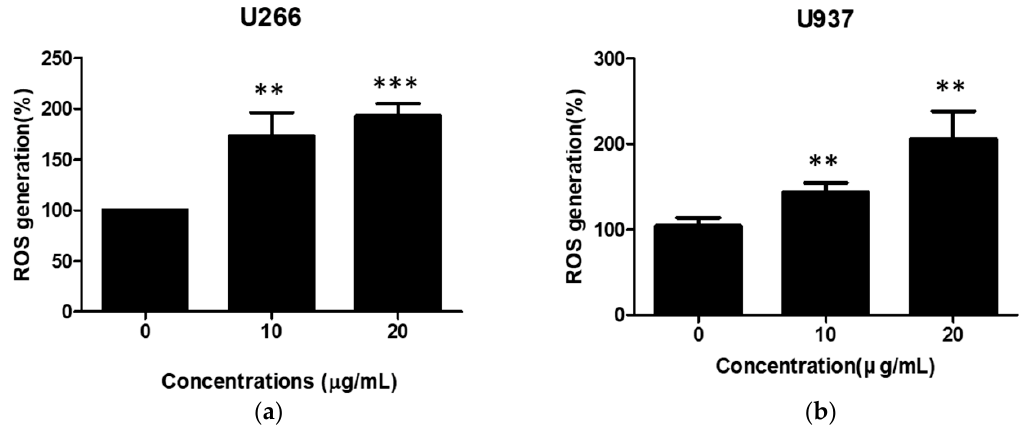
Figure 5. Effect of SSD on reactive oxygen species (ROS) generation in U266 and U937 cells. U266 ( a ) and U937 ( b ) cells were exposed to SSD (10 or 20 µ g/mL) for 24 h (sample number n = 3). ROS production was analyzed using 2 (cid:48) ,7 (cid:48) -Dichlorofluorescein diacetate (DCFDA) by cellular reactive oxygen species detection assay kit. Results are presented as the means ± SD of three independent experiments. ** p < 0.01; *** p < 0.001 versus the control